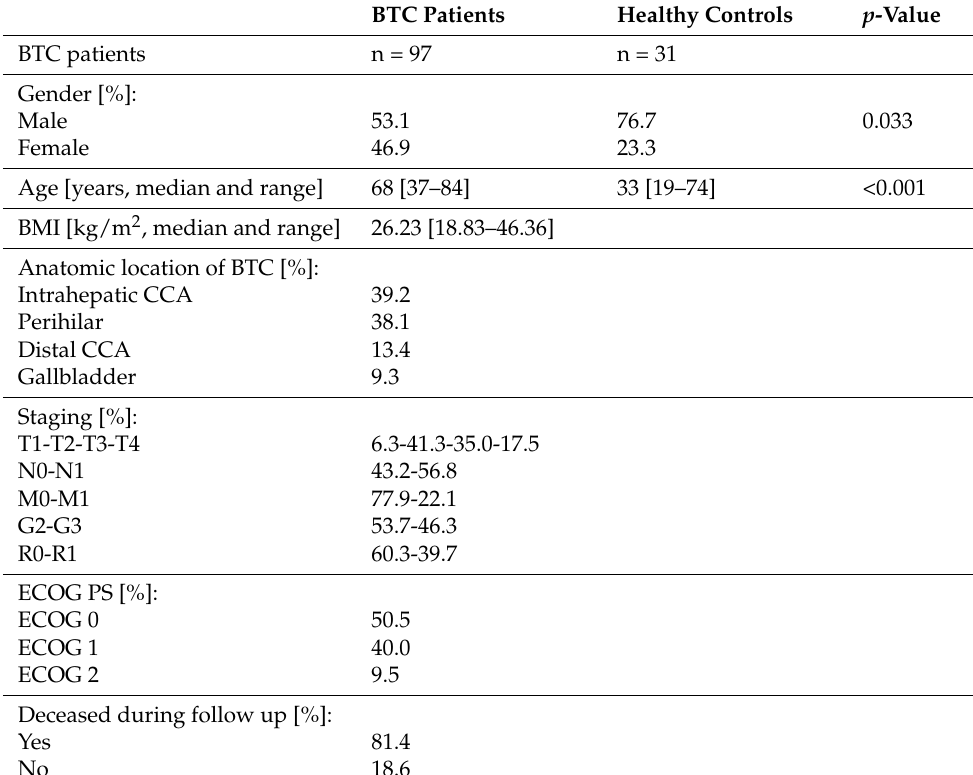
Table 1. Characteristics of the study